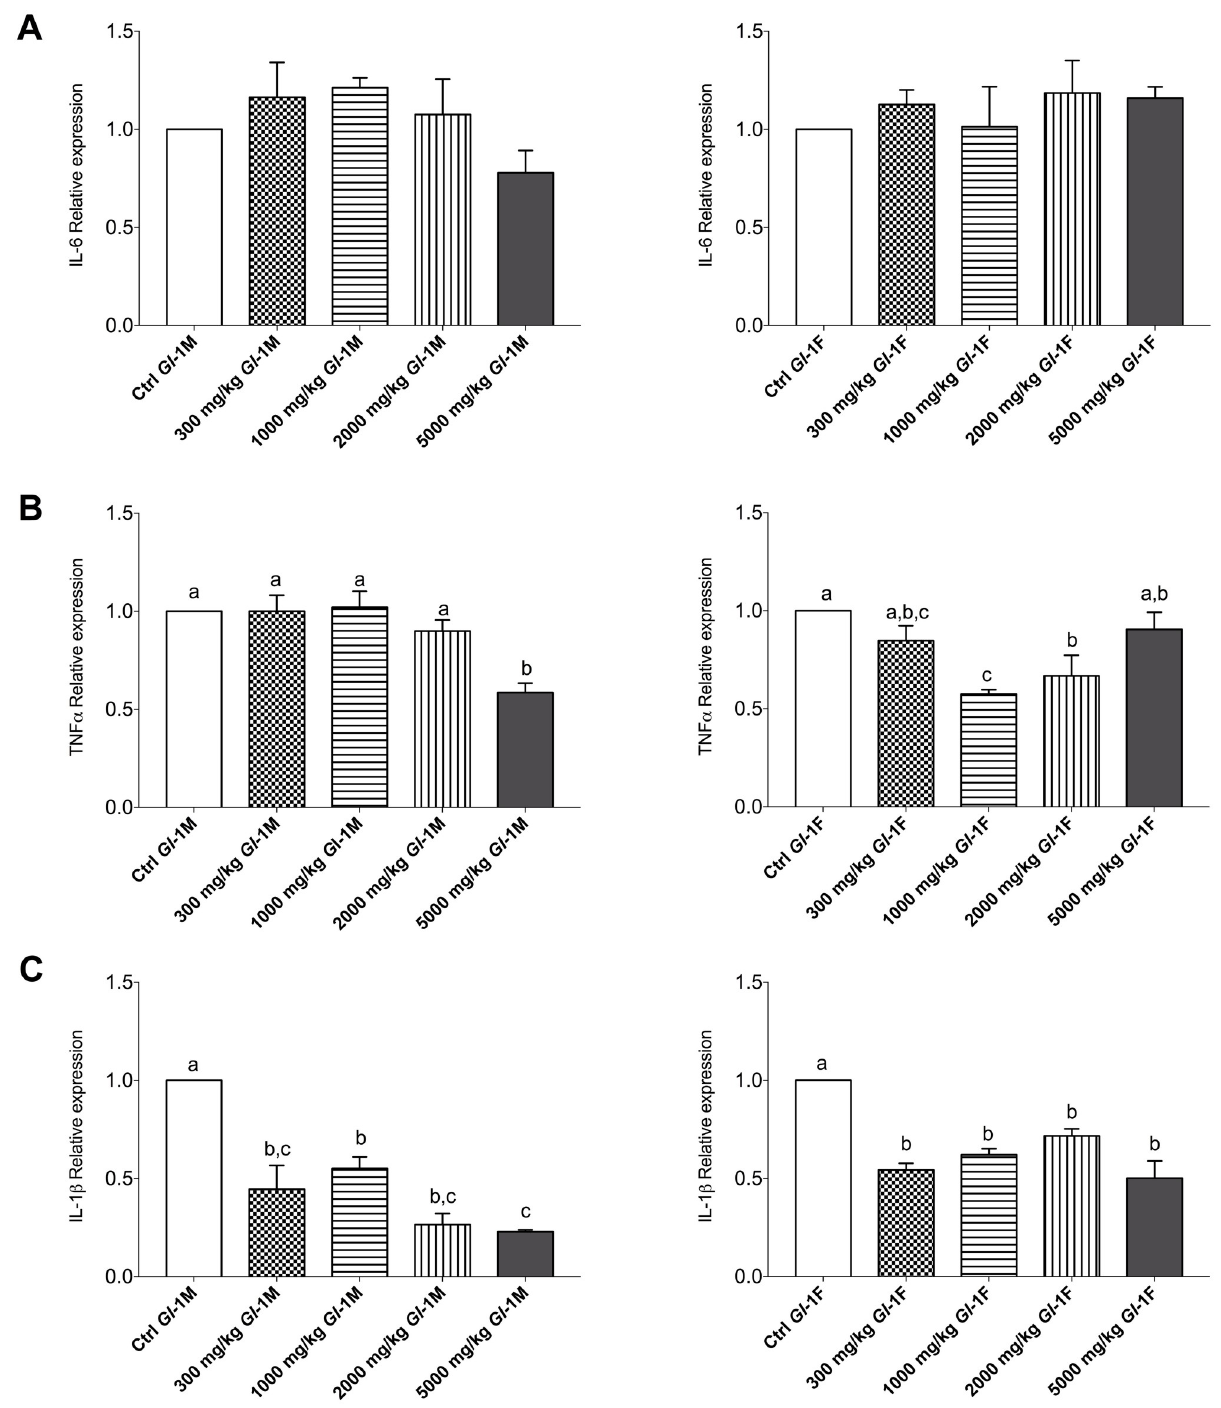
Fig 11. Expression of genes linked to inflammatory responses in liver tissue from male (M) or female (F) Wistar rats fed with the control diet (Ctrl) and different doses of the standardized Gl -1 extract of Ganoderma lucidum for 14 experimental days. A: IL-6. B: TNF- α . C: IL-1 β . Data are presented as mean ± SEM per experimental group. Different letters on a column indicate significant differences, p < 0.05. Values ( p ) correspond to one-way ANOVA from Tukey’s multiple comparison test. The dose administered per experimental group is described in the materials and methods